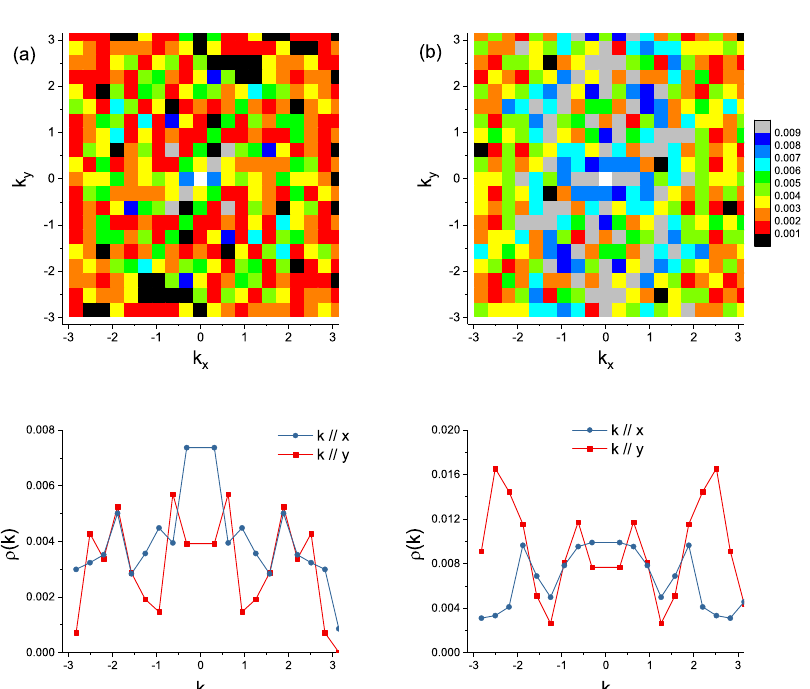
Figure 7: The LDOS Fourier transform ρ ( k ) profile of (a) a symmetric model, and (b) a nematic model. The models are identical to those in Fig. 6. Yet there are 40 impurities on a smaller 20 × 20 system. (c) and (d) are ρ ( k ) along the ˆ x and ˆ y